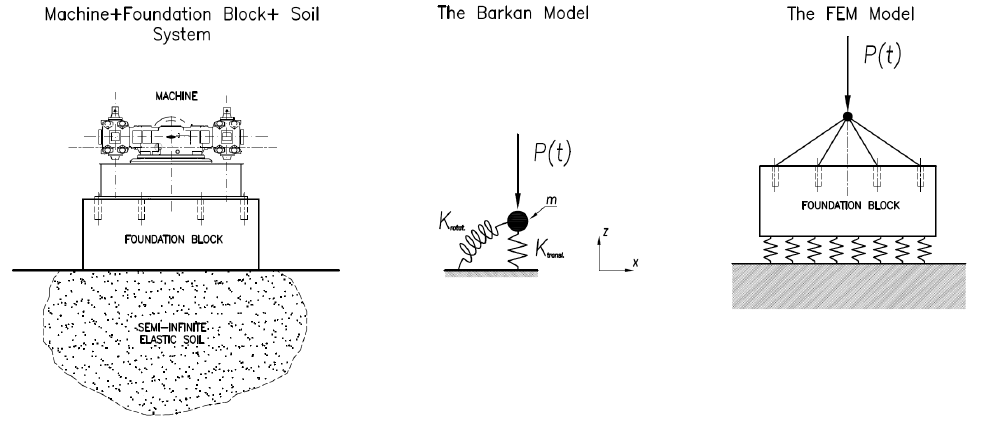
Figure 5. Machine + foundation block + soil system models.